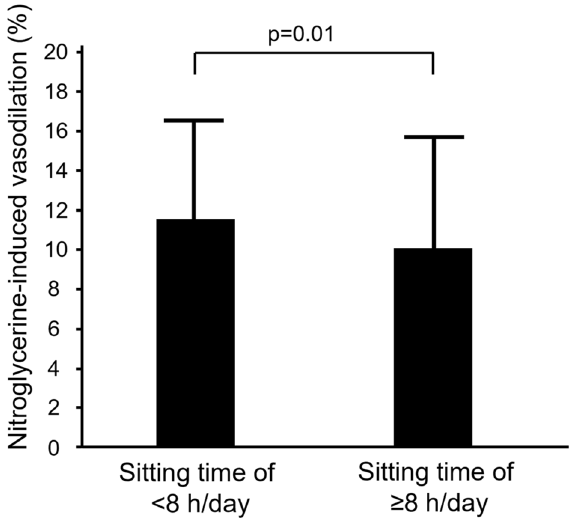
Figure 3. Bar graphs show nitroglycerine-induced vasodilation in subjects with sitting time on a non-working day of < 8 h/day and subjects with sitting time on a non-working day of ≥ 8